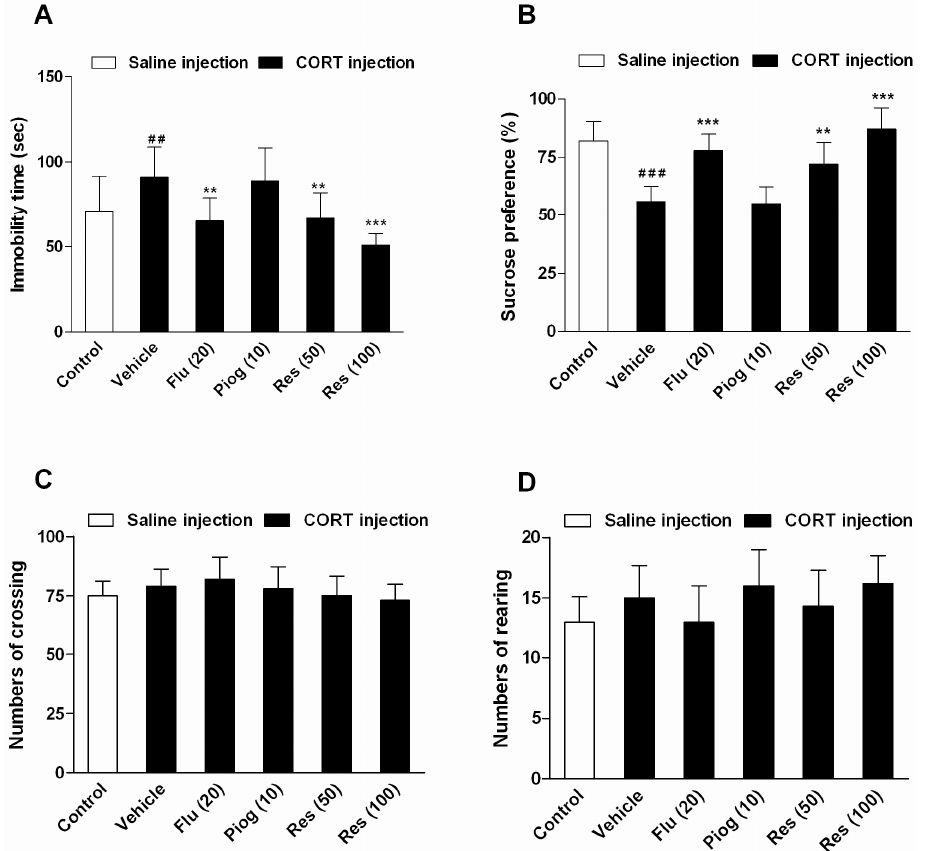
Figure 3. Effects of resveratrol on the depressive-like behaviors induced by CORT. ( A ) The immobility time in forced swimming test (FST); ( B ) The sucrose preference in sucrose preference test (SPT); ( C ) The numbers of crossing in open field test (OFT); ( D ) The numbers of rearing in OFT. Data were expressed as the mean ± S.E.M. ( n = 10). ## p < 0.01 and ### p < 0.001 vs . control group. ** p < 0.01 and *** p < 0.001